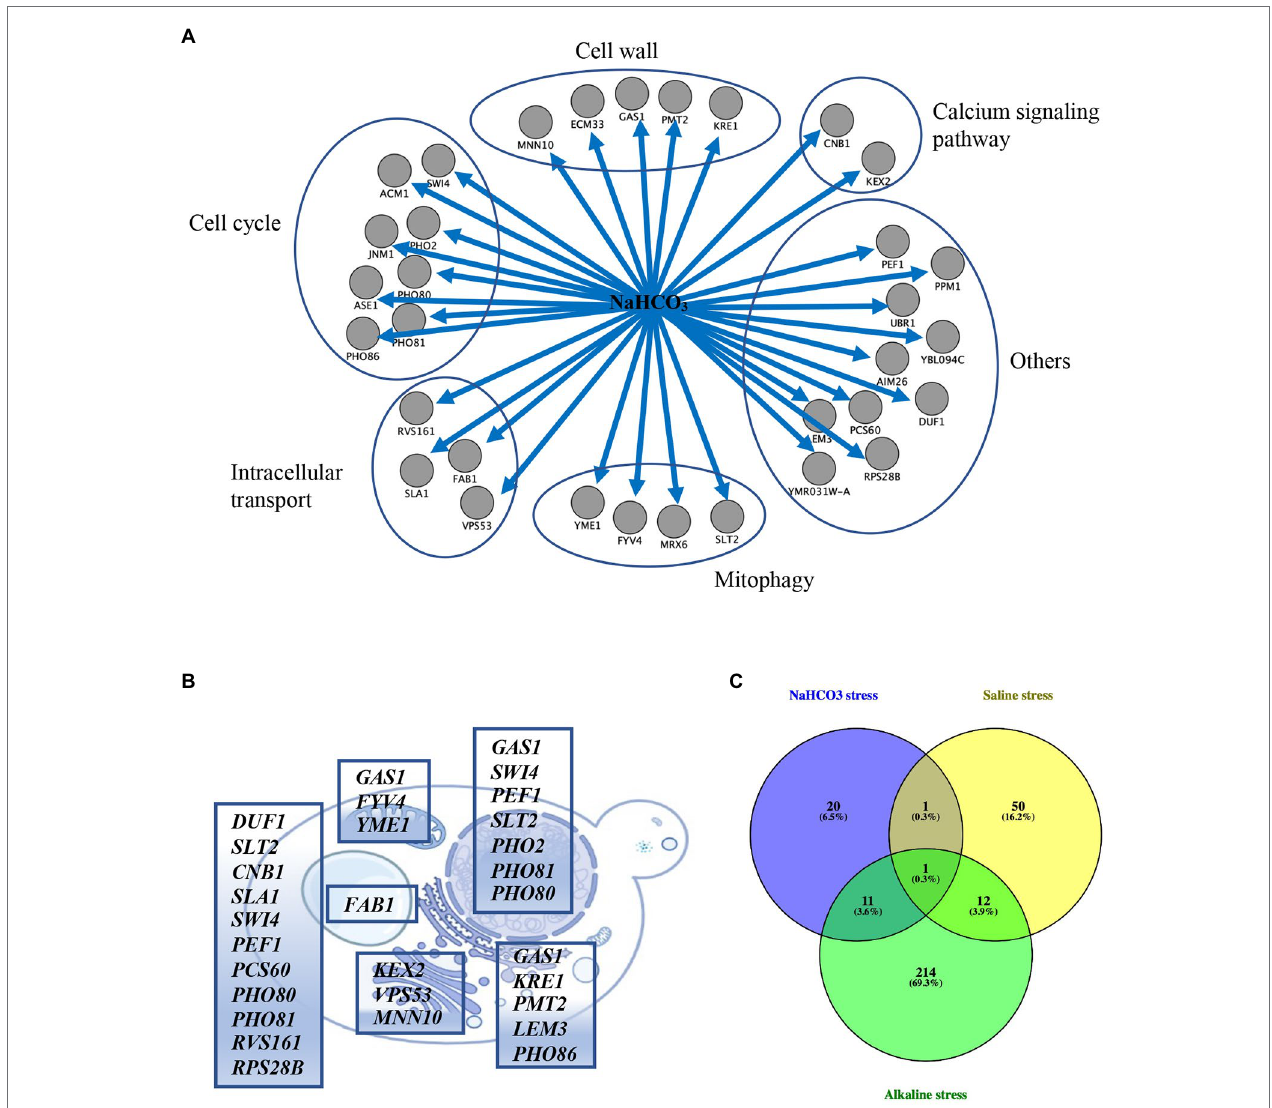
FIGURE 3 | Enrichment and localization analysis of the 33 selected genes. (A) Functional classification of the 33 genes. (B) Cellular localization of the 33 selected genes. These genes are distributed in the cytoplasm, nucleus, Golgi, vacuole, endoplasmic reticulum, and mitochondrion. (C) Venn diagram analysis of the 33 selected genes vs. the 238 and 64 genes whose deletion results in growth defects under alkaline and saline stress,